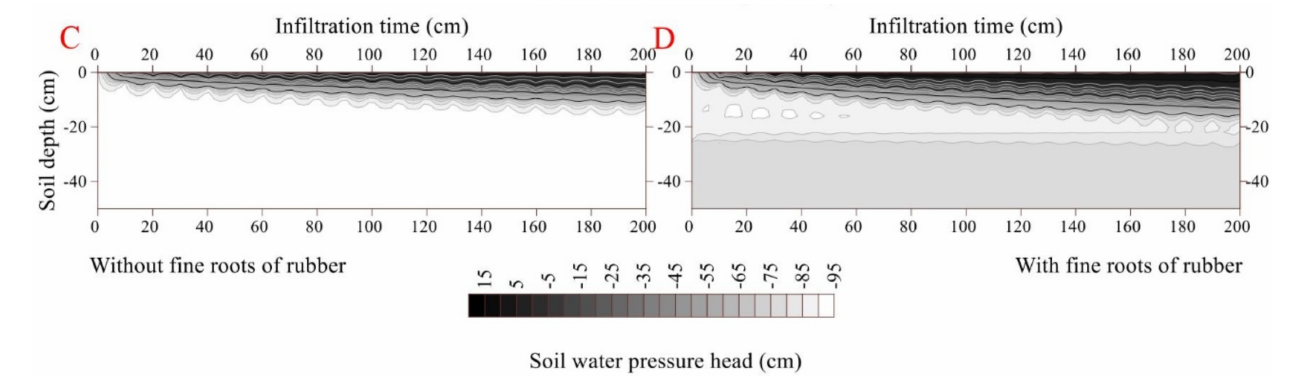
Figure 5. Dynamic characteristics of volumetric water content and soil water pressure head as a function of infiltration time in the soil profile without fine rubber roots ( A , C ). Dynamic characteristics of volumetric water content and soil water pressure head as a function of infiltration time in the soil profile with fine rubber roots ( B , D